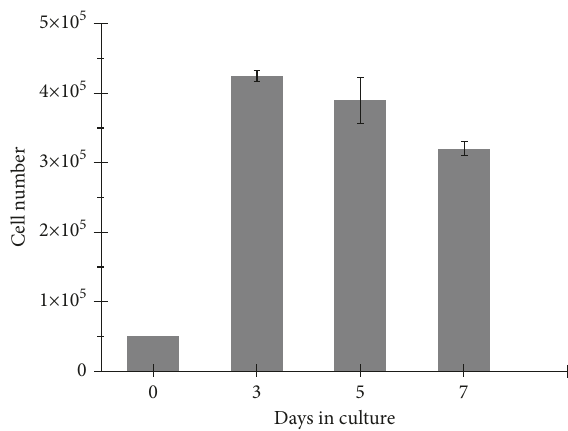
Figure 5: Viable C2C12 cells grown on the microfilament scaffold.